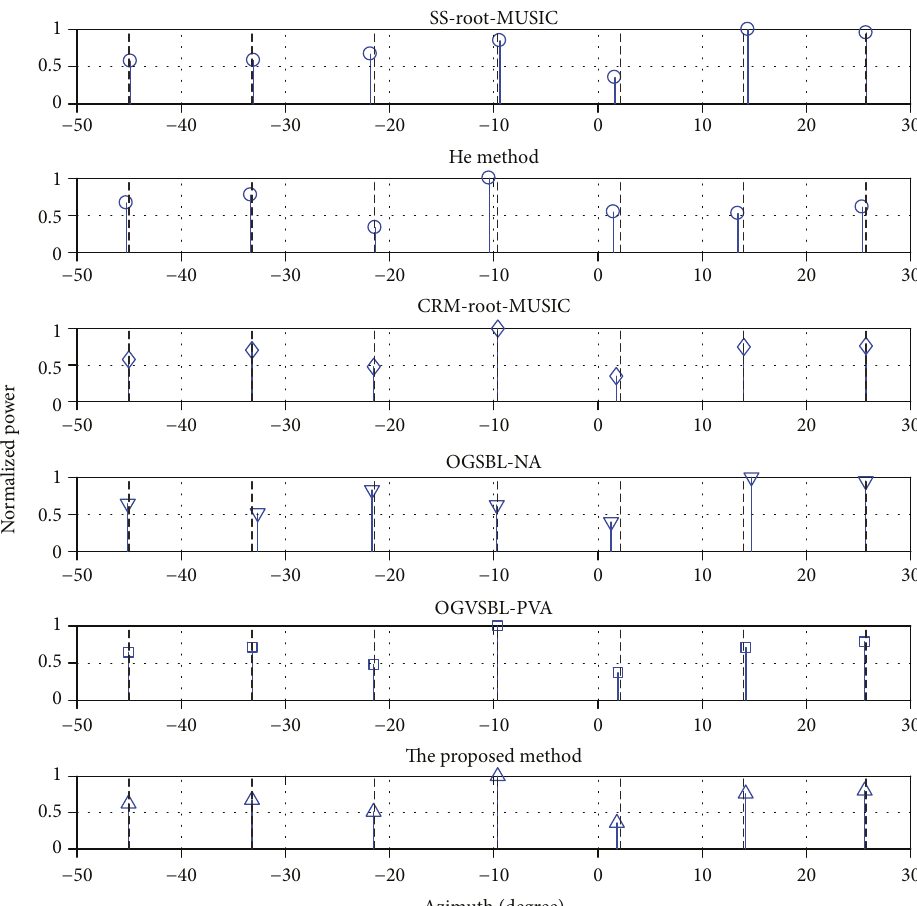
Figure 4: Normalized spatial power in nonuniform noise case for M = 6 , K = 7 , N = 500 , and SNR = 0dB